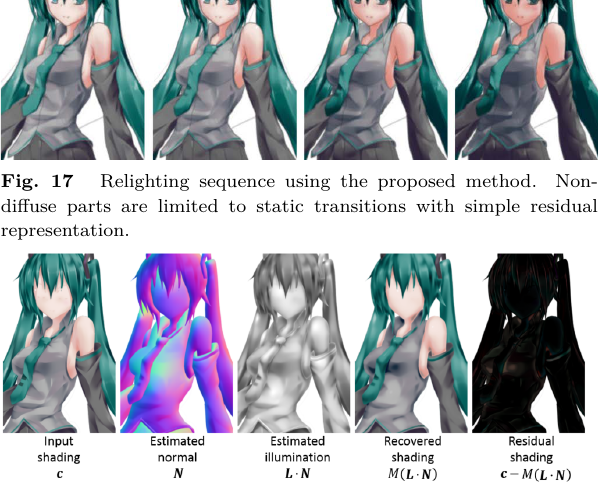
Reflectance and shape estimation results for a real illustration. Non-diffuse parts are encoded as residual